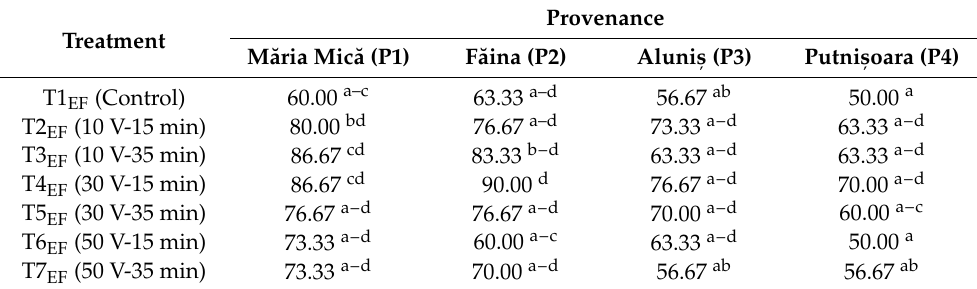
Table 1. Seed germination percentage (%) depending on the interaction between EF treatments and